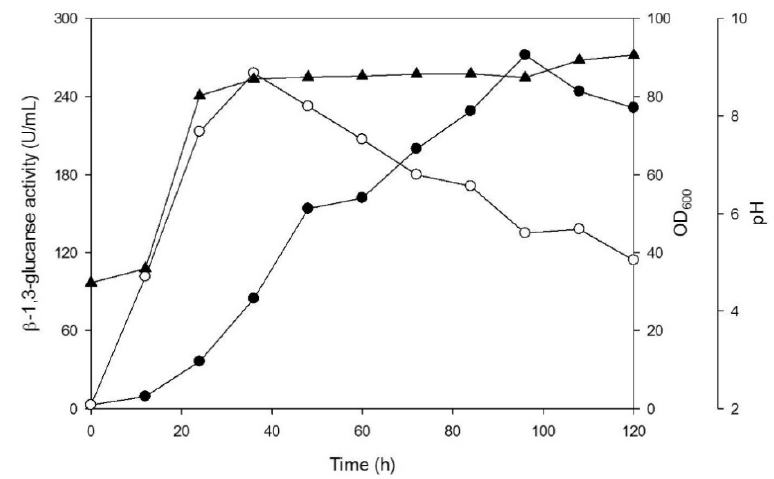
Figure 2. Time course of β -1,3-glucanase activity in a Y. lipolytica transformant (pYLSC1- 13g ). (- • -) extracellular β -1,3-glucanase activity; (- ○ -), Optical density (OD) 600 nm; (- -), pH. The culture conditions were: temperature 25 °C; shaking speed 250 rpm.